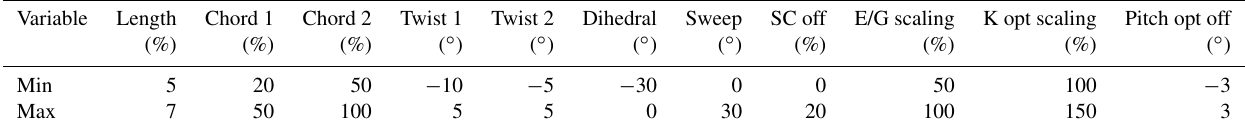
Table 1. Design variables and their range. Minimum (min) and maximum (max) values of planform design variables result in the “tip 1” and “tip 2” shapes shown in Fig.